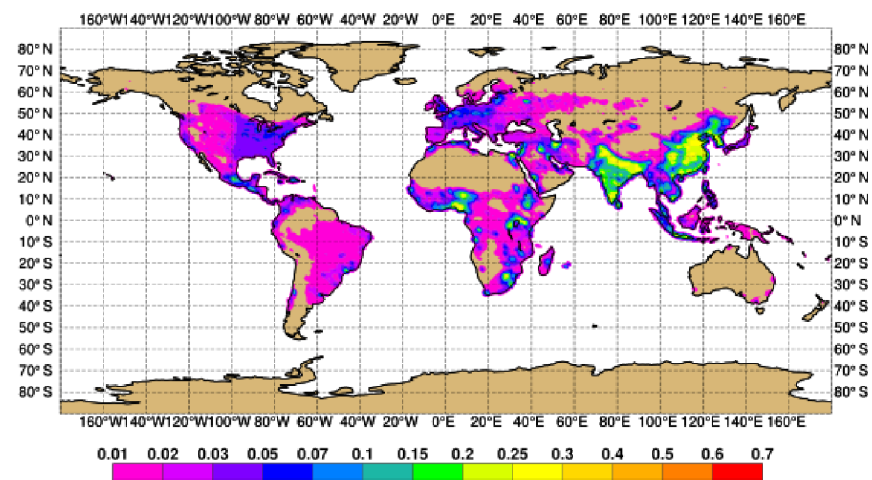
Figure 1. Emissions of anthropogenic secondary organic aerosol (SOA) in 2017 (µgm − 2 s − 1 ), as used in cycle 45R1 of the IFS.